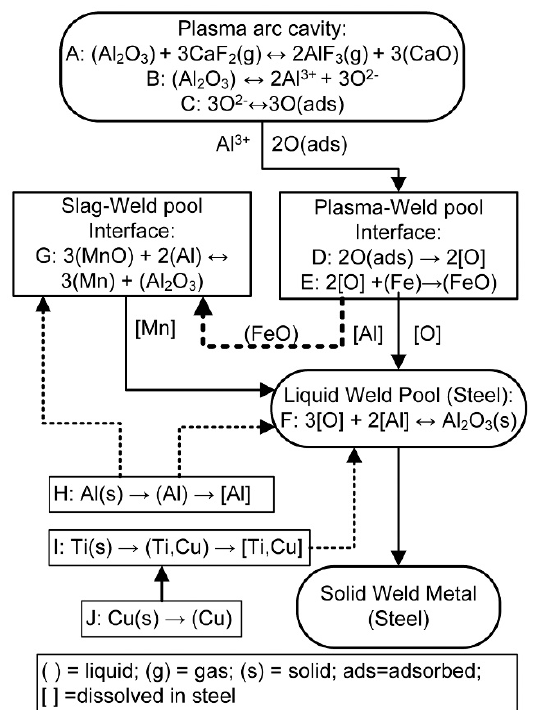
Figure 6. SAW reaction flow diagram with Al, Ti, and Cu powder addition reactions.